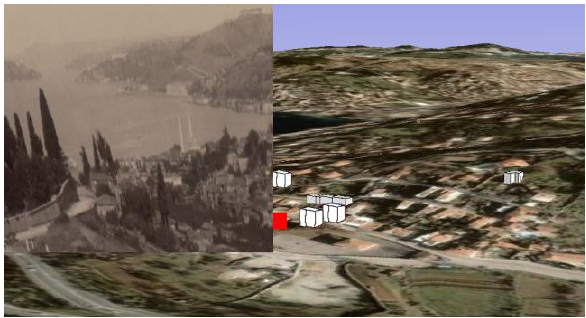
Figure 10. The location of the actual